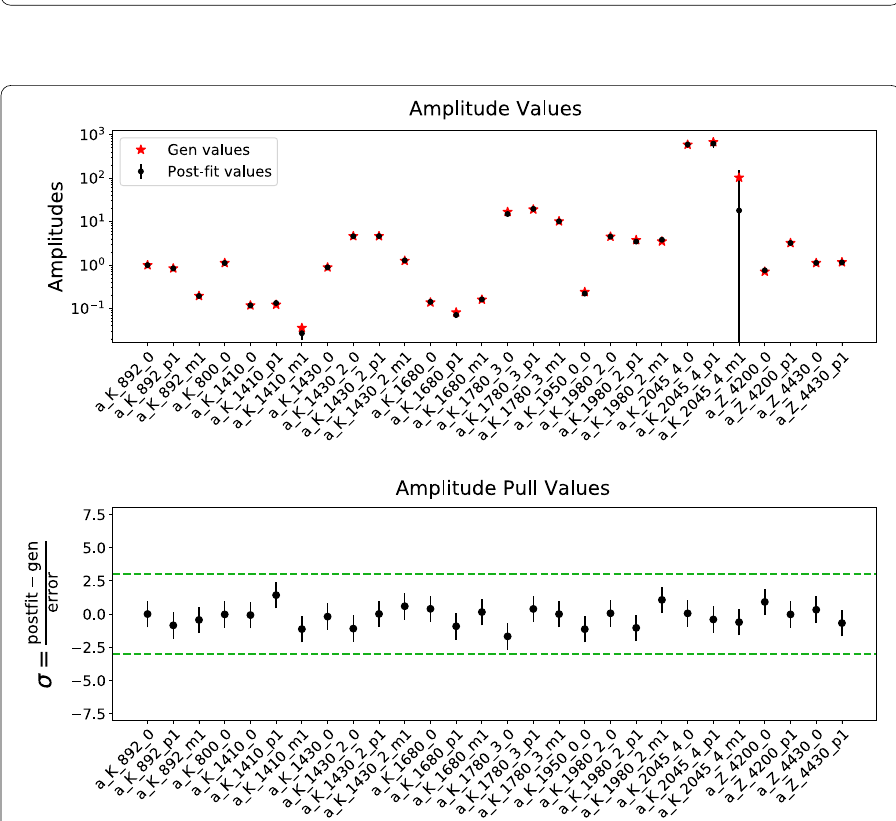
Fig. 11 Comparison of generated and post-fit values of the amplitude parameters (above) and the corresponding pull distribution (below) obtained from a fit to events generated with ten K ∗ s Z (4430) model including efficiency and 15% background contribution. The green lines define a ± 3 σ